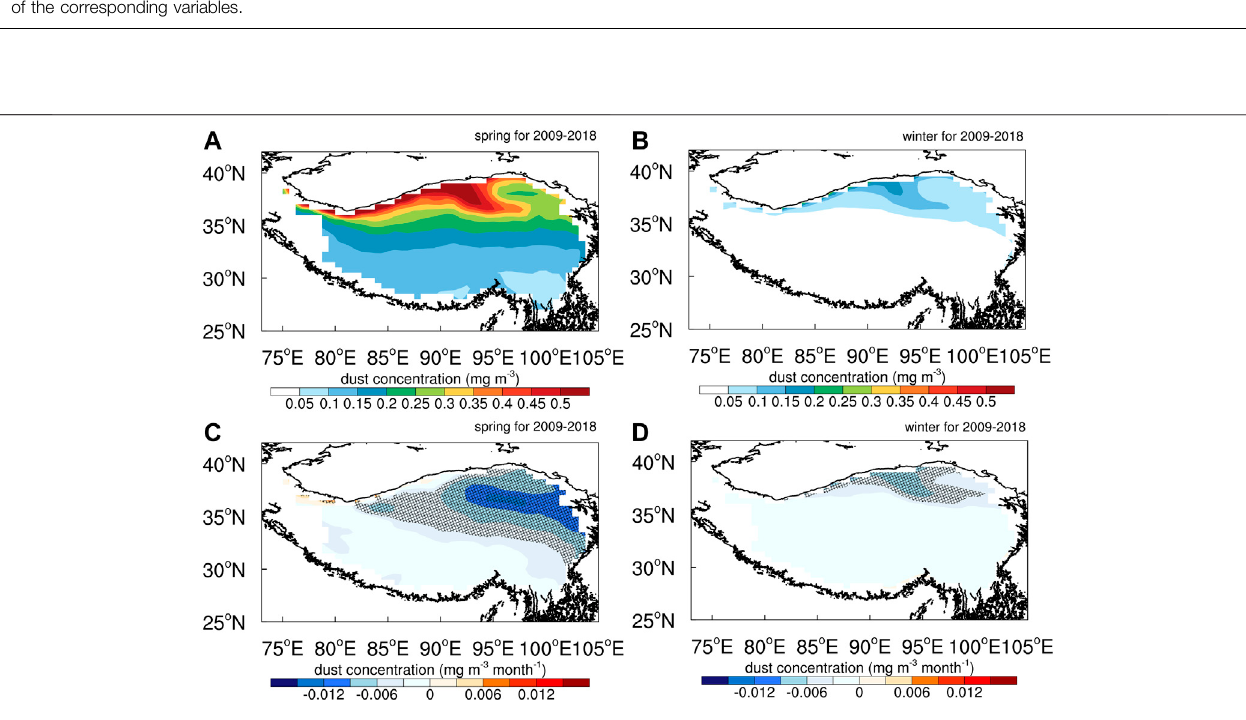
Frontiers in Environmental Science |